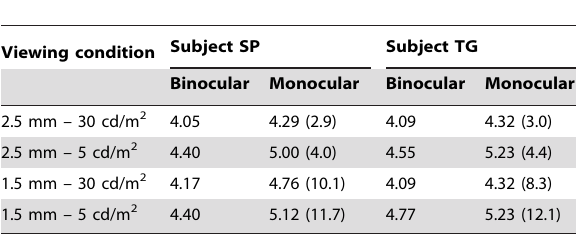
Table 1. N atural pupil diameter (in mm) during binocular / monocular VEP recordings and for two luminance levels.